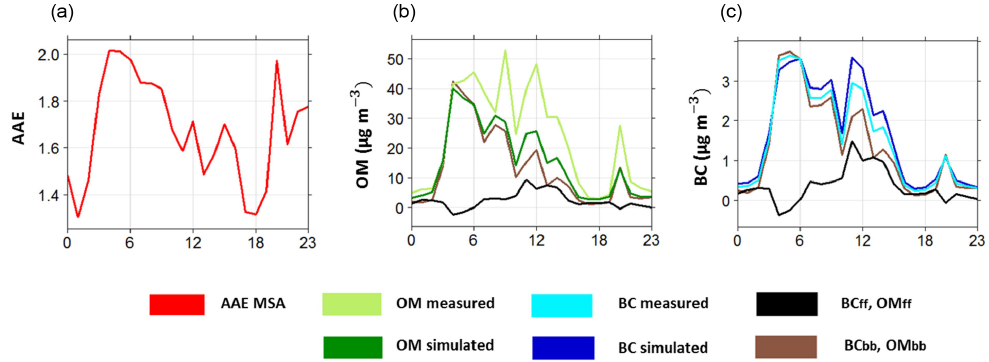
Figure 8. Daily cycle of (a) AAE, (b) Measured OM and simulated OM as the sum of OM ff and OM bb contributions, (c) Measured BC and simulated BC as the sum of BC ff and BC bb contributions, during a wildfire episode (23 July 2012) at